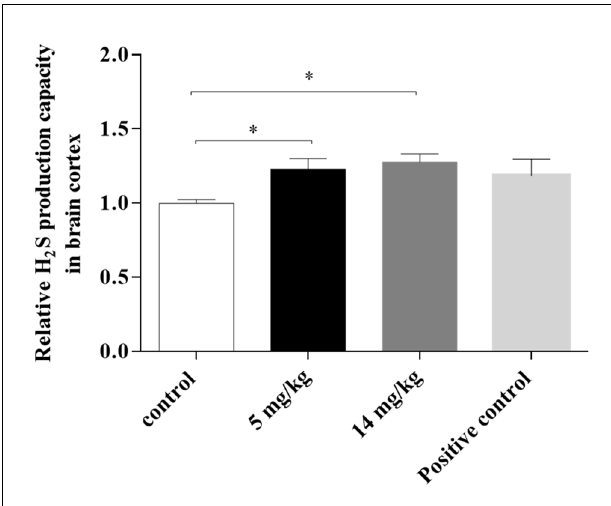
FIGURE 6 | H 2 S production capacity in the brain cortex of mice treated with 5 or 14 mg/kg NaAsO 2 at 24 h. Changes in H 2 S production capacity were evaluated by a lead sulfide method. Bars show the IntDen function measurement normalized to the respective control group, mean ± SE, n = 7. Untreated mouse liver tissue was used as a positive control. The data were analyzed using one-way ANOVA with Tukey’s post hoc analysis. Different superscript symbols above each column indicate statistically significant differences; ∗ P ≤